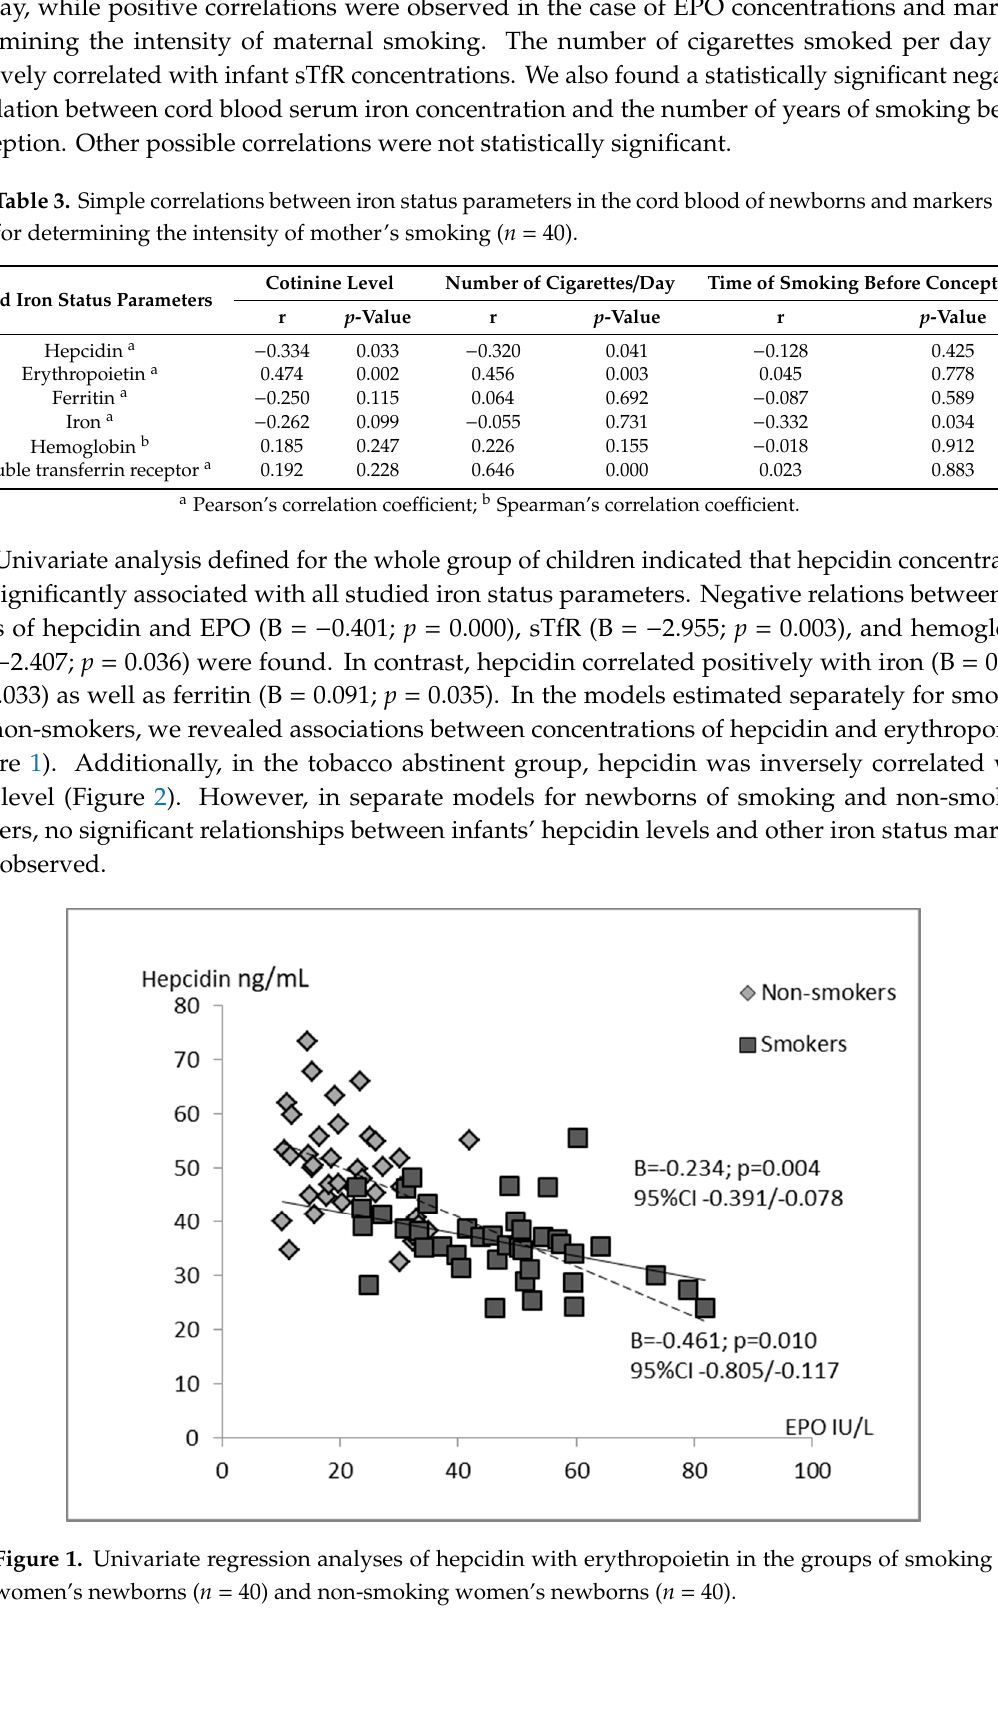
Figure 2. Univariate regression analyses of hepcidin with soluble transferrin receptor in the groups of smoking women’s newborns ( n = 40) and non-smoking women’s newborns ( n = 40). Table 4 contains the results of multivariate regression analysis, confirming a negative association between hepcidin and erythropoietin concentrations in the whole group of newborns ( β = − 0.531; p = 0.001) and the group of smokers ( β = − 0.565; p = 0.011). In these subjects, EPO explained 44.6% and 31.9% of the hepcidin variance, respectively. We did not find this relation in the infants of tobacco abstinent women. A tendency towards a positive association between cord blood hepcidin concentrations and the pregnant women’s smoking habit was also observed ( β = 0.178; p = 0.073).